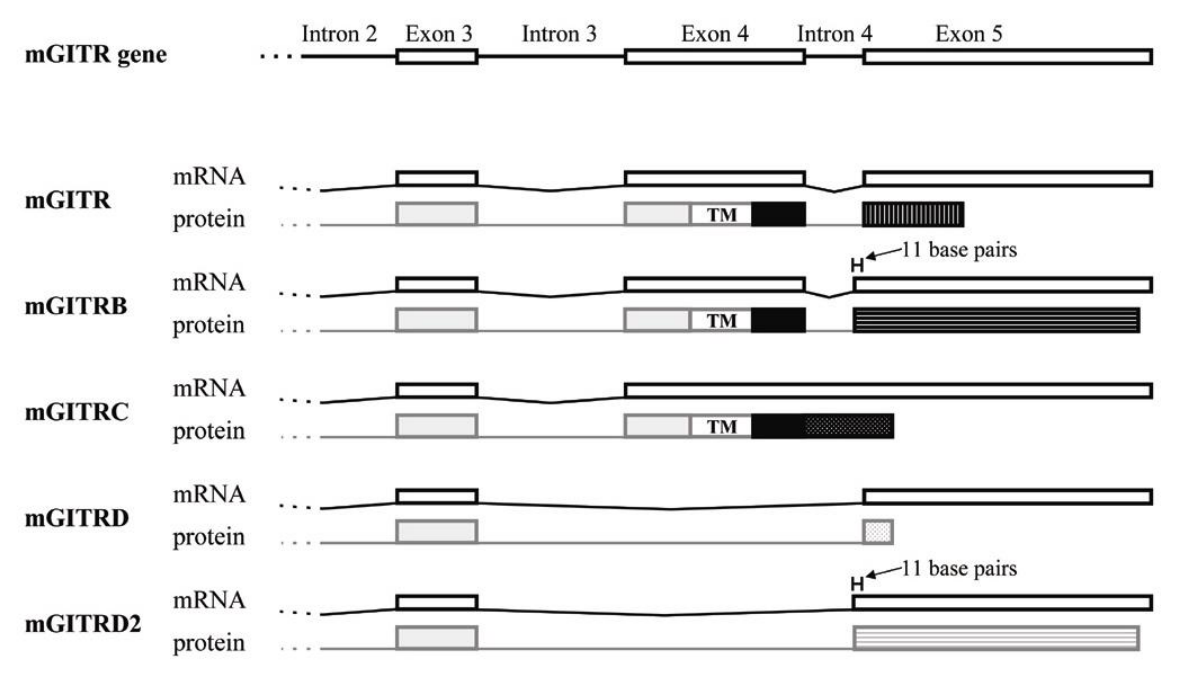
FIGURE 6 . Murine GITR splicing